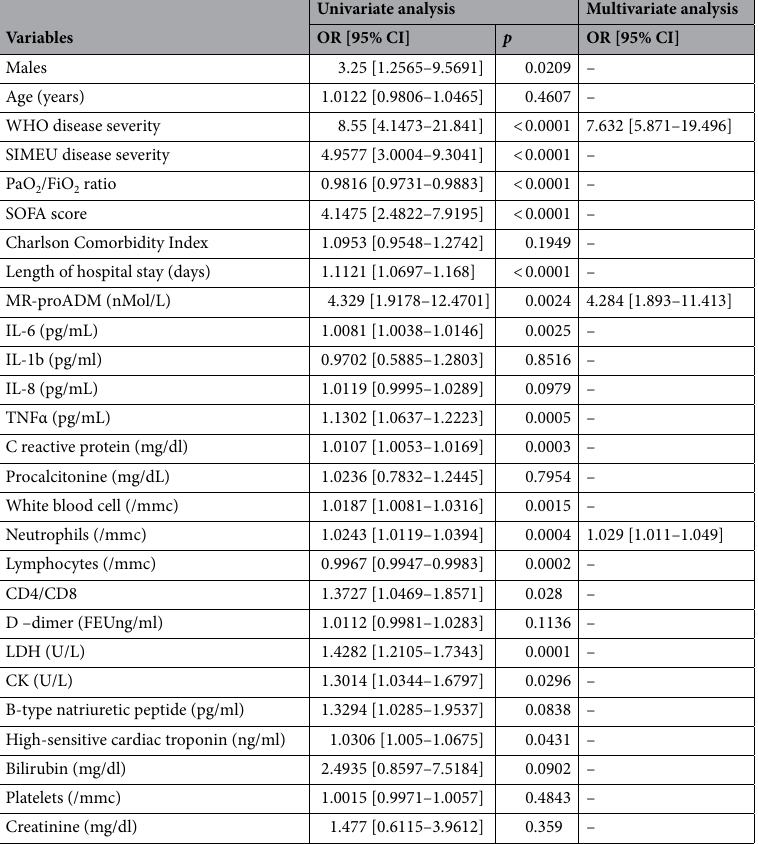
Table 2. Factors influencing death or IOT (univariate & multivariate analysis). The variables selected for multivariate analysis were: gender, WHO disease severity, MR-proADM, PaO2/FiO2 ratio, IL-6, CD4/CD8, Neutrophils count.